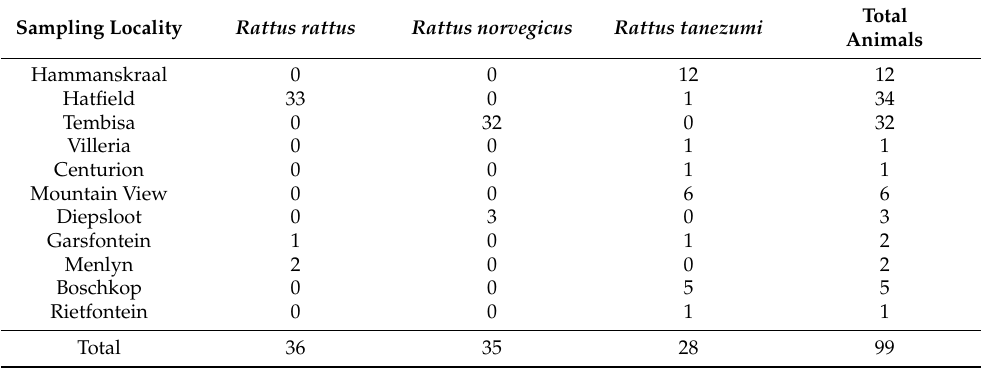
Figure 1. Sampling map of Rattus samples collected across 11 different sampling sites across the Gauteng Province. A total of 99 Rattus samples comprising of three Rattus species, viz. Rattus rattus (n = 36), R. norvegicus (n = 35), and R. tanezumi (n = 28) were collected and screened for haemotropic mycoplasmas. ( A ) indicates the number of Rattus samples collected per sampling site while ( B ) indicates the Rattus species composition per site. Table 1. Number of each Rattus species ( Rattus rattus , R. norvegicus and R. tanezumi ) sampled at 11 sampling localities across the Gauteng